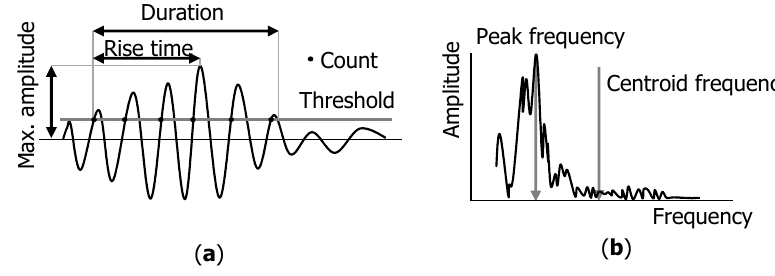
Figure 1. Characteristics of an AE signal: ( a ) temporal wave, ( b ) FFT spectrum.